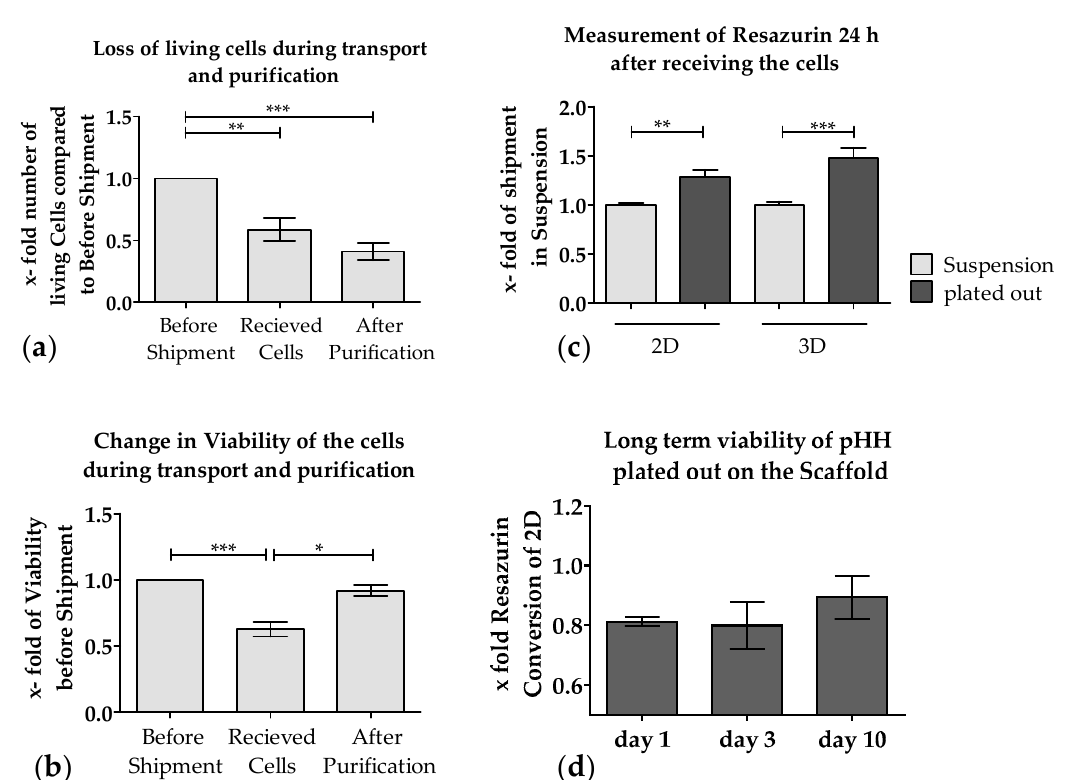
Figure 3. Effect of shipment on the viability and adherence of PHHs. Freshly isolated PHHs were shipped overnight in cold storage solution. Total cell numbers and the viability of the cells were measured before shipping, before and after Percoll purification. ( a ) Amount of living PHHs decreased during transport and purification. ( b ) Viability of PHHs can be increased by using Percoll density purification. ( c ) Viability (Resazurin conversion) of PHHs shipped overnight either adherent or in suspension (with purification and plating upon arrival). Data shown represent an average of N = 9 (PHH were shipped and purified nine times independently ( a , b ). ( c ) (N = 3, n = 20) cells were shipped three times independently, cultured both directly on scaffold and onto plates (2D) or in parallel in suspension and then plated after shipment. ( d ) shows long time viability of PHH plated out on scaffold over 10 days that were quantified by measurement of the resazurin conversion (values of 3D were normalized to the values of 2D on the same day N = 3, n = 3 (mean ± SEM). * p ≤ 0.05; ** p ≤ 0.01; *** p ≤ 0.01).